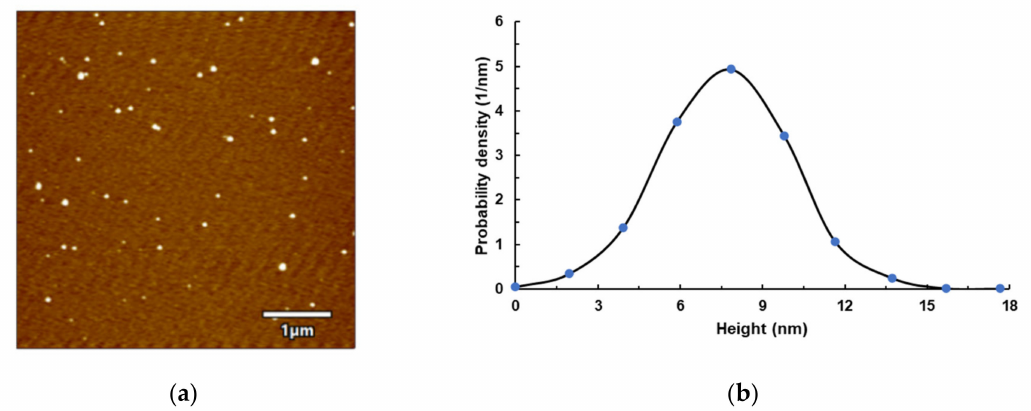
Figure 4. AFM images of lignin and height probability distribution profile: ( a ) P45T80t60 lignin image; ( b ) lignin height distribution